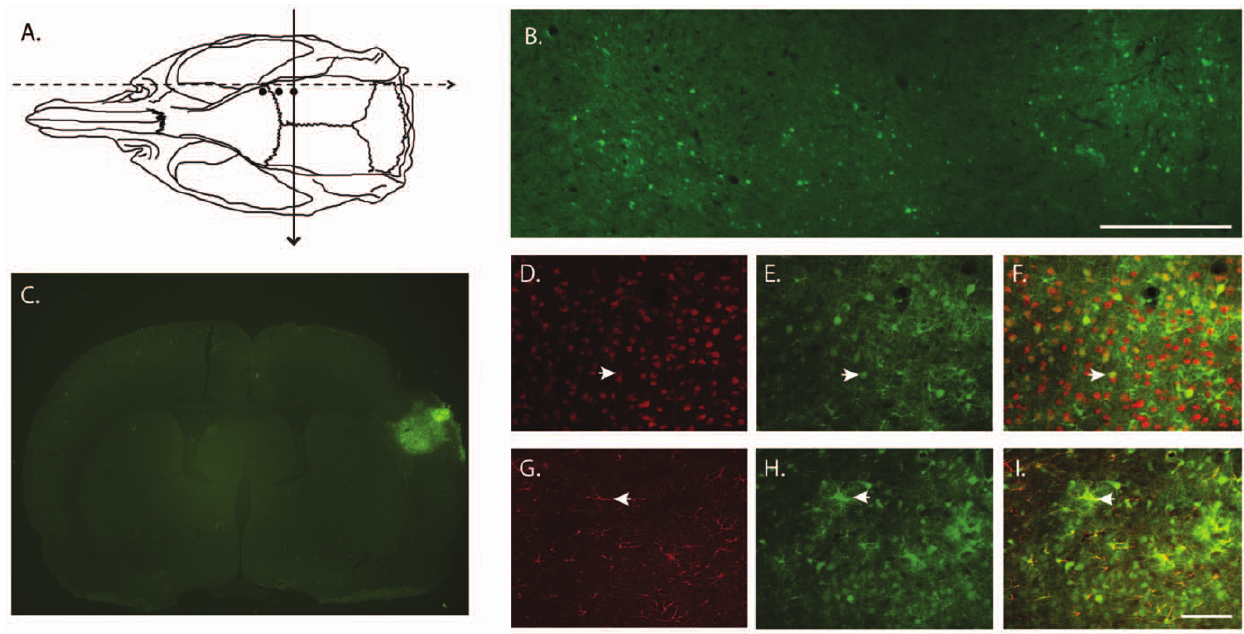
Figure 2. Transduction of rat cortex by three site injection of AAV-GFP serotype 1. (A) Schematic representation of rat skull with injection sites (black dots). (B) Dashed line points to brain section cut in a sagittal plane showing 3 injections sites by GFP fluorescence (green;scale=0.5 mm). (C) Coronal section of injection site showing expression of GFP from a dsAAV1eGFP injection. Coronal sections immunostained for neuronal marker, NeuN (red; D–F) or the astrocytic marker, GFAP (red;G–I) show that GFP (green) colocalizes to both neurons and astrocytes in the cortex. Arrowheads illustrate example of NeuN (D,E) or GFAP (G,H) double-labeled cells. Scale bar=100 um.